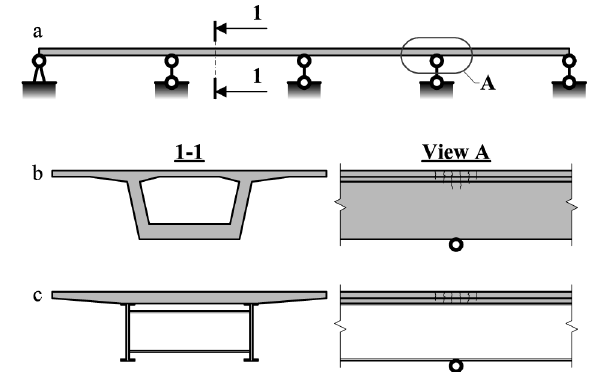
Fig. 1. Sketch of a continuous bridge (a); cracking pattern of concrete (b) and composite (c) sections